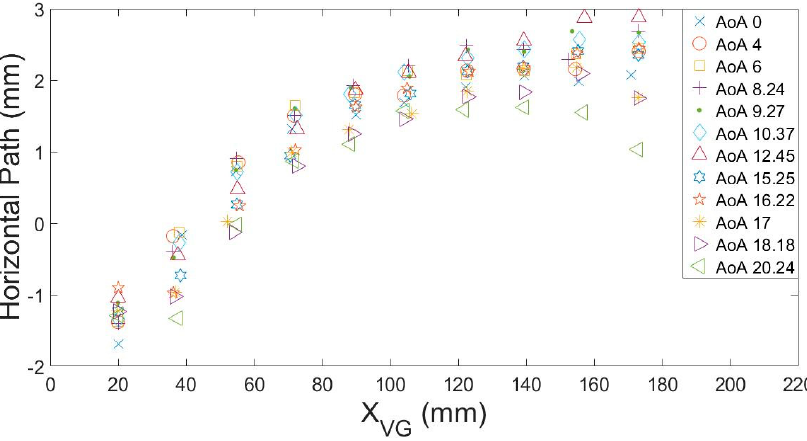
Figure 8. Comparison of horizontal peak vorticity paths for different AoAs.